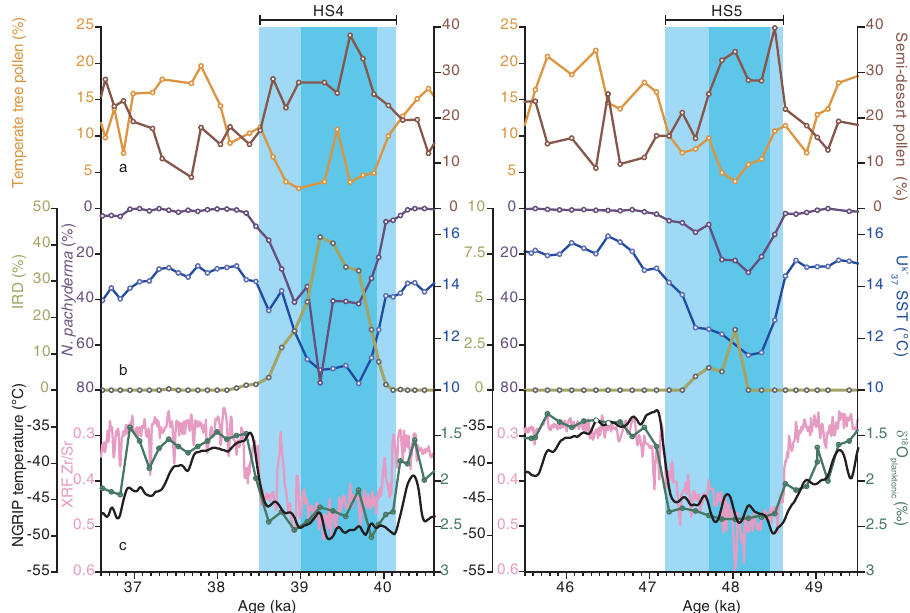
Fig. 5 MD01-2444 records across the intervals 36.6 – 40.6 ka and 45.5 – 49.5 ka. a Temperate (Mediterranean + Eurosiberian) tree and semi-desert ( Artemisia and Chenopodiaceae/Amaranthaceae) pollen percentages (note different scales). b Percent ice-rafted detritus (IRD) (note different scales in HS4 and HS5), N. pachyderma (inverse scale) and alkenone-based U k' 37 SST. ( c ), XRF Zr/Sr ratio and planktonic ( G. bulloides ) foraminiferal δ 18 O. Also shown is the temperature reconstruction from the NGRIP ice-core 49 . All records are plotted on the WD2014 timescale 41 . Vertical blue bars denote HS4 and HS5; light blue bars denote the initial cooling and fi nal warming phases, while dark blue bars denote the phases of maximum cooling (see